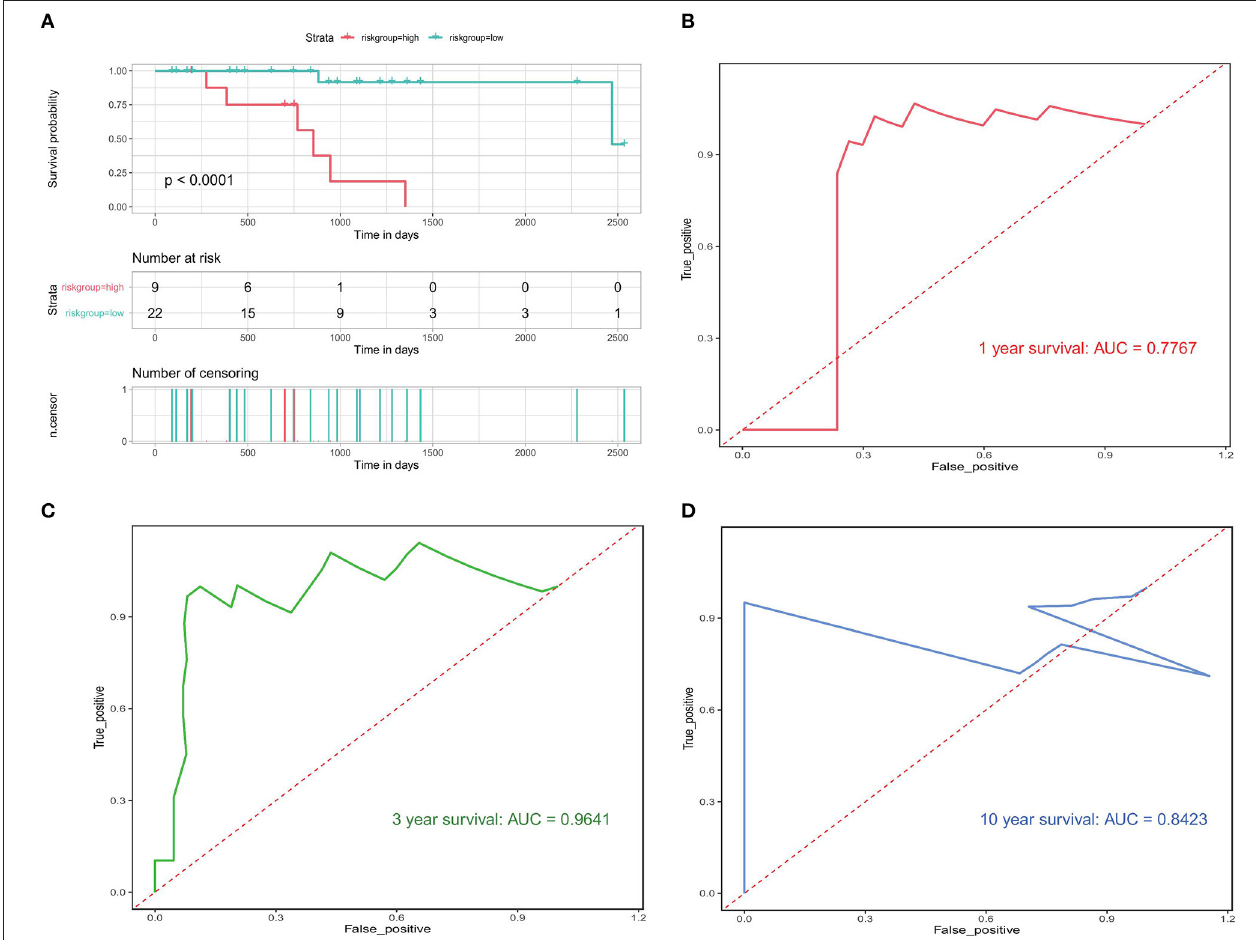
FIGURE 10 | Validation of bone metastasis-associated prognostic models. (A) Kaplan-Meier analysis of the high first risk group in the validation set. (B–D) Validation of time-dependent ROC analyses focused on 1, 3, and 10